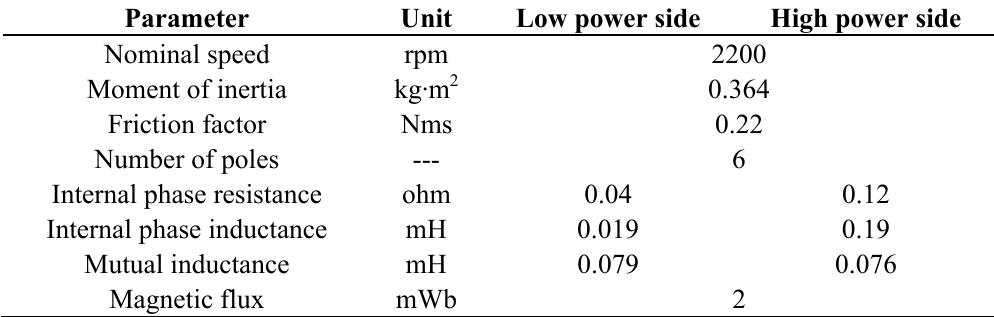
Table 1. Parameters of the flywheel electric